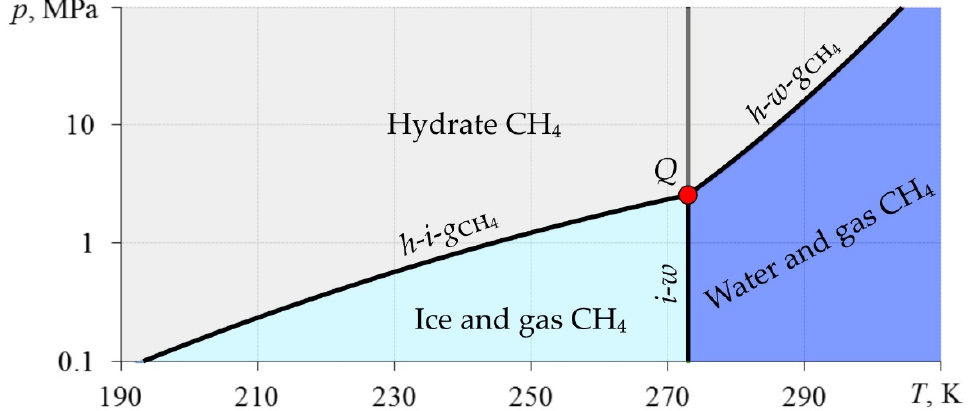
Figure 2. Phase diagram of the “H 2 O–CH 4 ” system. i - w —phase equilibrium “ice–water”; h - i - g CH4 — phase equilibrium “methane hydrate–ice–methane”; h - w - g CH4 —phase equilibrium “methane-hydrate–water–methane”; Q is the quadruple point at which all four phases